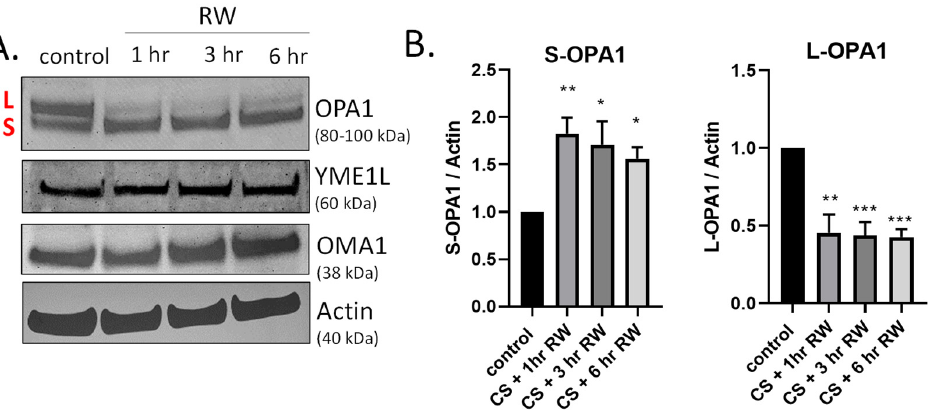
Figure 2. Time course of OPA1 proteolytic processing during CS + RW. ( A ) Representative western blots (where each lane is loaded with 25 µ g NRK cell lysate protein) show OPA1 proteolytic processing, evidenced by loss of long form or L-OPA1 (~100 kDa) and increased short form or S-OPA1 (~80 kDa) as early as 18 h CS + 1 h RW in NRK cells. CS + RW did not alter protein expression of YME1L (~60 kDa) or OMA1 (~38 kDa). ( B ) Densitometric analysis using actin as a loading control shows that 18 h CS + 1, 3, and 6 h RW significantly increased S-OPA1 and decreased L-OPA1. Data were evaluated using one-way ANOVA followed by Tukey’s post-hoc test. * p < 0.05, ** p < 0.01, *** p < 0.001. n = 4 independent experiments were performed. Data are shown as mean density ±SEM (bars; arbitrary units).